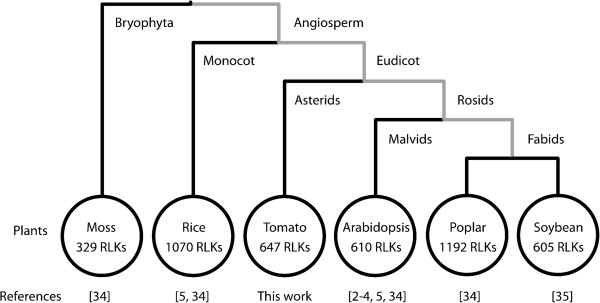
Cladogram of plants whose RLK superfamily has been characterized. The RLK superfamily size ranges from 329 (moss) to 1192 (poplar) members. The RLK superfamily expanded after divergence between the Bryophyta and Angiosperm lineages and independently expanded in the plants of the Angiosperm lineage. Dramatic expansions were observed in rice and poplar.